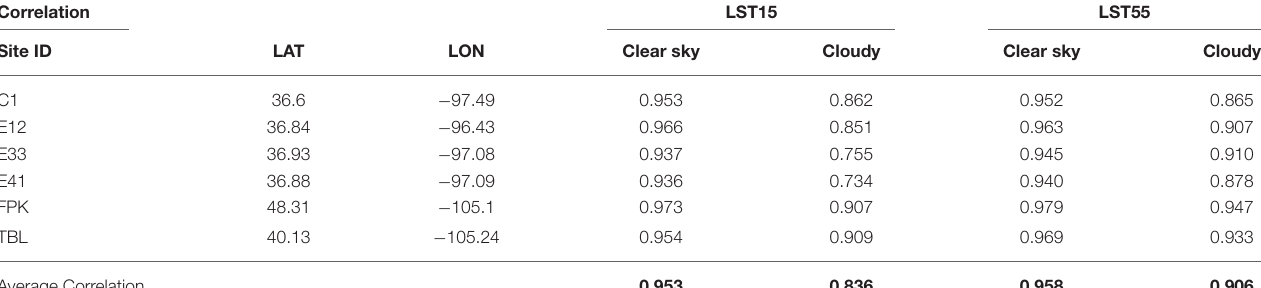
TABLE 3 | Correlation of MW-TIR coupled LST validated against in-situ observations (Jan. 26–Dec. 31 2018); statistics of clear sky pixels and cloudy pixels are separated. Correlation